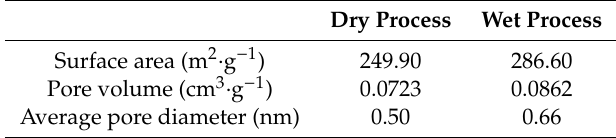
Figure 2. N 2 adsorption-desorption isotherms and pore size distribution of the biochar. Table 1. Textural structure of the char samples blended by dry and wet